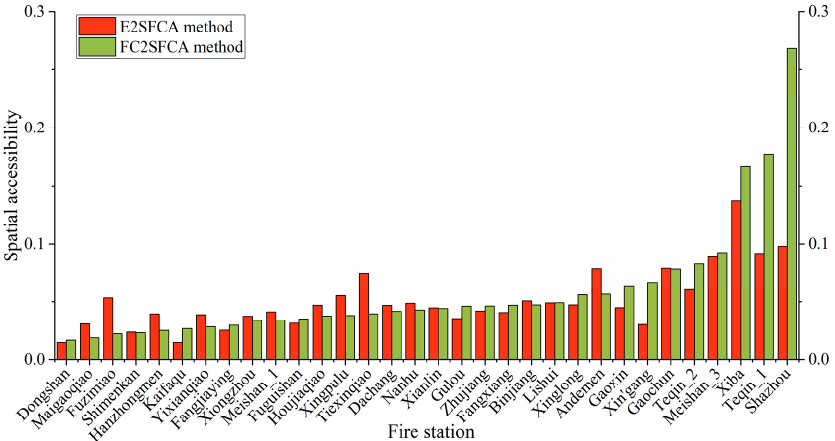
Figure 8. The spatial accessibility of fire stations.